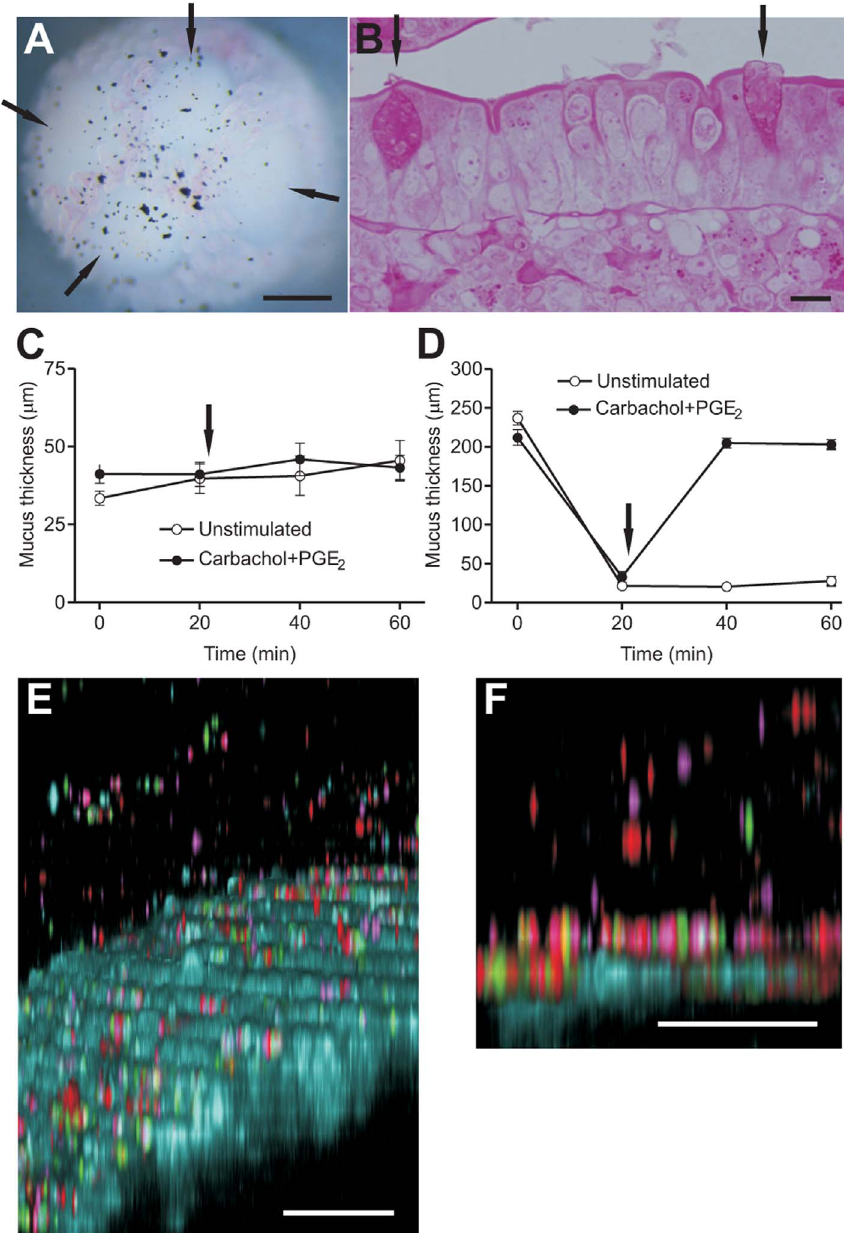
Figure 1. Mouse ileal Peyer’s patches are covered by a mucus layer. (A) Stereo microscope image of an ileal explant containing a PP. Domes are indicated by black arrows. Charcoal particles were added to visualize the otherwise transparent mucus layer (bar=0.5 mm). (B) Two mucus filled goblet cells (black arrows) in a dome stained by PAS (bar=10 m m). (C) Mucus on top of the FAE was removed and remaining mucus thickness measured every 20 minutes for an hour (open circles; n=6) or mucus thickness was measured at time 0 and 20 min and a combination of carbachol and PGE 2 , 10 m M of each, was perfused after the second measurement (arrow, closed circles; n=6). (D) Initial mucus thickness was measured on the villi of the PP, mucus was removed and remaining mucus thickness measured at time 20 min. Half the number of explants were left unstimulated (open circles; n=10) and half of the explants were stimulated with carbachol and PGE 2 (10 m M of each; arrow), and mucus thickness was measured at time 40 and 60 min (closed circles; n=10). (E) Mucus penetrability to beads the size of bacteria was assessed by confocal imaging of mouse ileal explants containing a PP. Tissue is visualized in blue and beads are red (0.5 m m), purple (1 m m) and green (2 m m). (F) To clarify how beads penetrate to the FAE surface, a flat section of the epithelium (blue) is shown. Note how some beads (red, purple and green) are suspended in the mucus. Bars in E and F=50 m m.